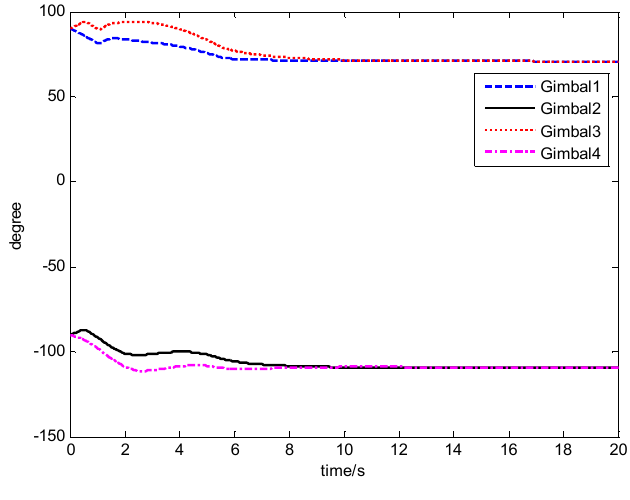
Figure 11. The gimbal angle of magnetically suspended